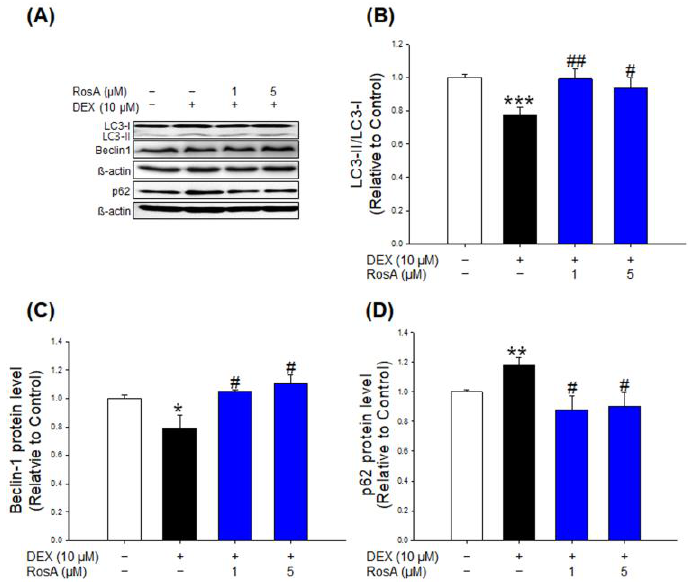
Figure 5. Effects of RosA on autophagy in DEX-treated C2C12 myotubes. ( A ) The expression of autophagy-associated proteins such as LC3, Beclin1, and p62. GAPDH was used as a loading control. ( B ) The quantitative of LC3II/LC3I ratio, ( C ) Beclin1, and ( D ) p62 expression levels. The graph shows a quantitative representation of the levels of protein. These results are presented as the means ± SD of three independent experiments: * p < 0.05, ** p < 0.01, *** p < 0.001 vs. control; # p < 0.05, ## p < 0.01 vs. DEX.